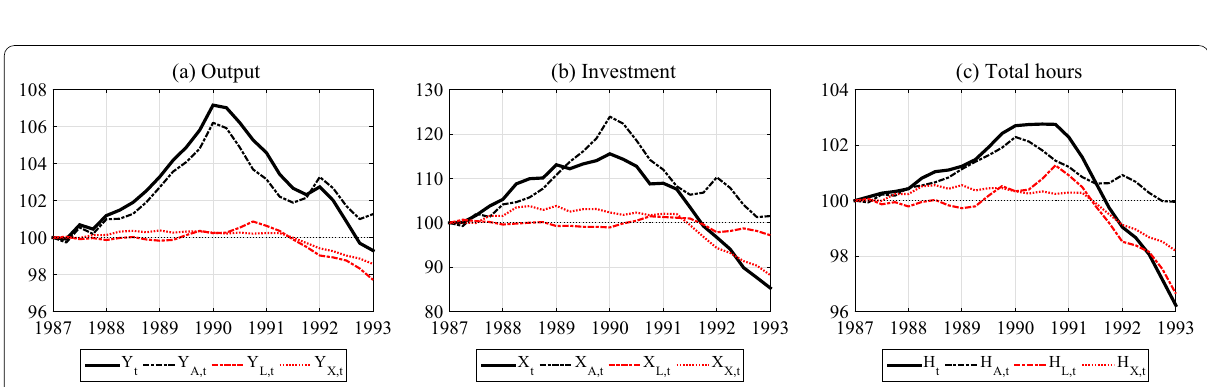
ν = 2 . As in Fig. 7, panel a depicts the investment wedge difference between the two lines represents the contribu- IW t (in solid black) together with the lending-deposit tion of investment frictions. Panel c depicts the counter- spread (dotted black). Panel b shows the investment factual path of output when holding financial frictions wedge IW t (in solid black) together with the financial- constant. According to our results, for both ν = 0.5 and ν = 2 , changes in investment frictions can explain the IW t (dotted black). The friction-corrected labour wedge (cid:31)